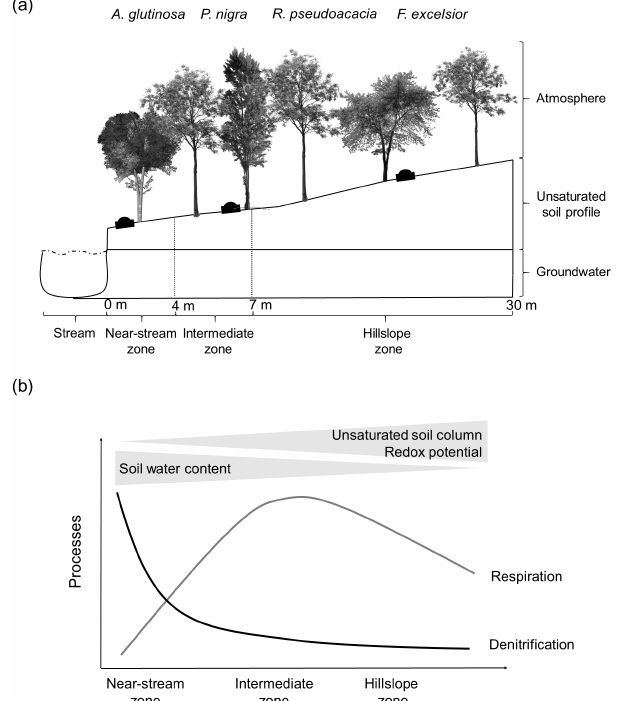
Figure 1. (a) Plot layout for the studied Mediterranean riparian for- est showing the three riparian zones and the location of the cham- bers ( n = 5 for each riparian zone). (b) Conceptual approach of the influence of riparian hydrology on soil microbial processes across a Mediterranean riparian zone. Soil water content decreases from the near-stream to the hillslope zone due to changes in groundwa- ter table, increasing unsaturated soil column and oxic conditions. Anaerobic processes (denitrification) occur under anoxic conditions while aerobic processes (respiration) are optimized under a moder- ate range of soil water content.